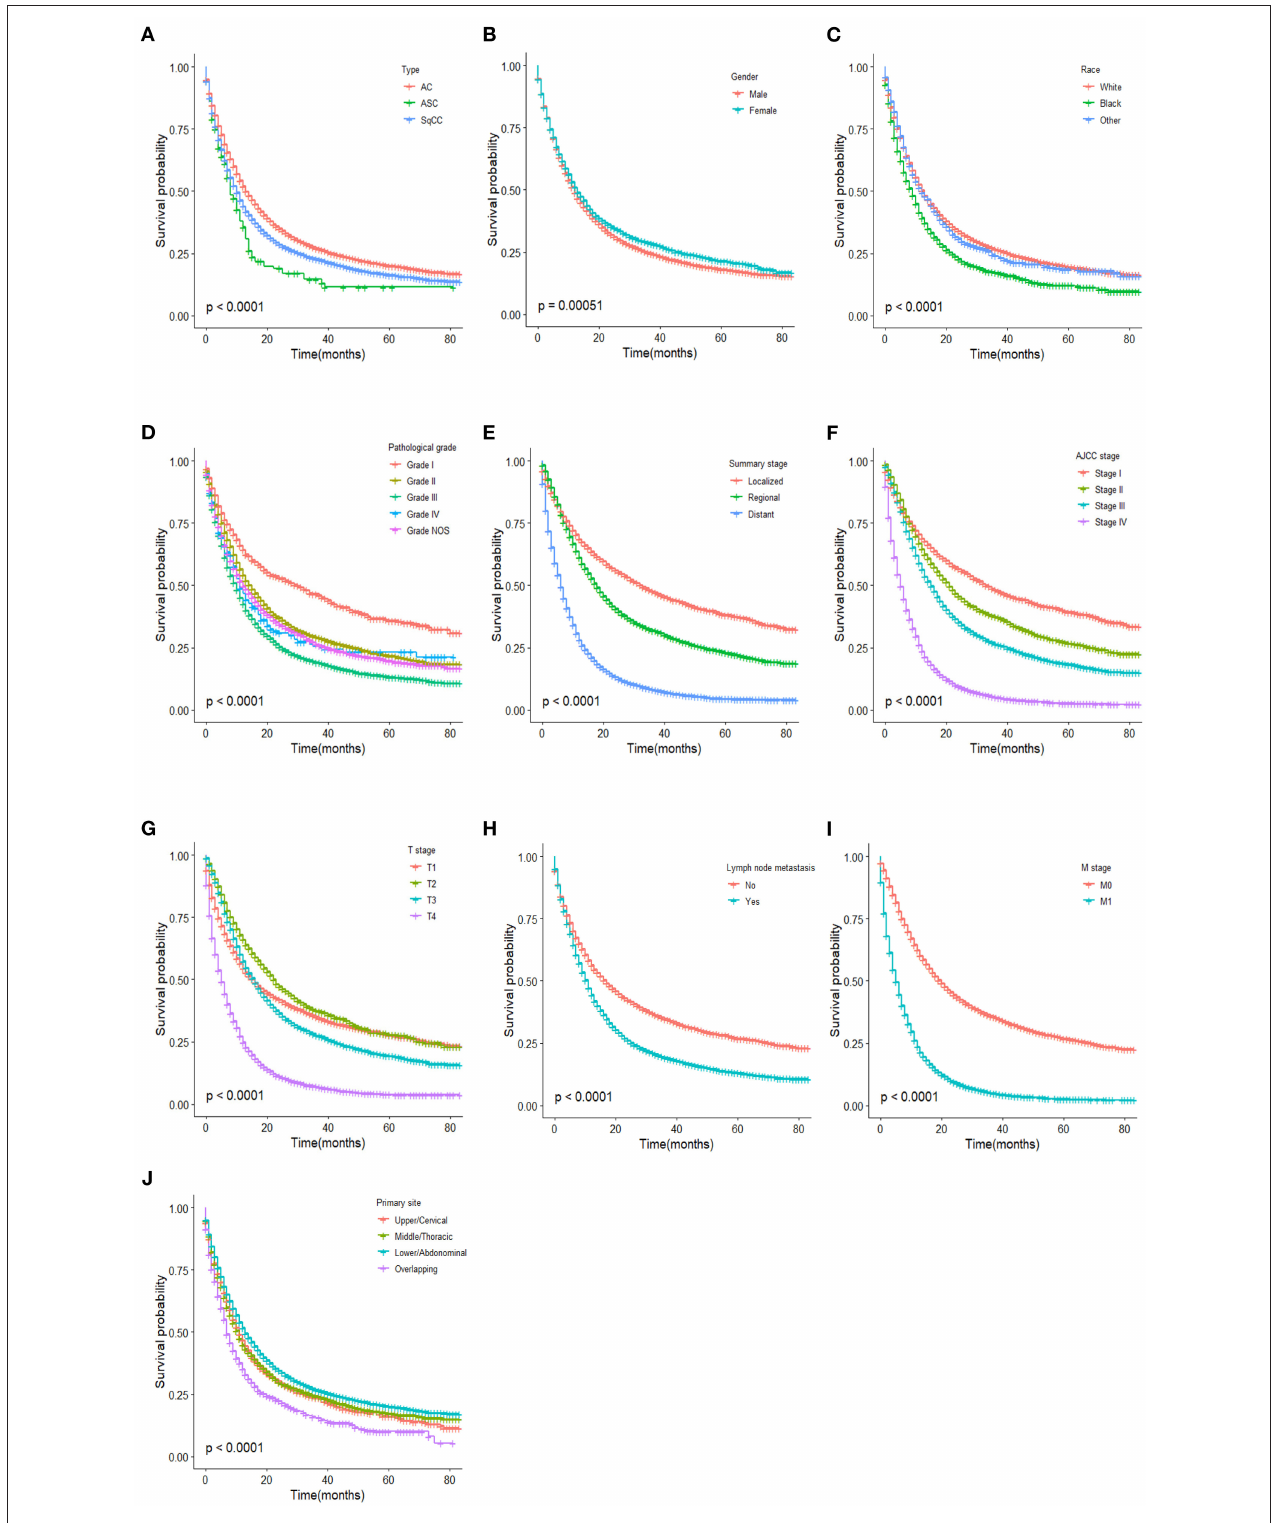
FIGURE 2 | Kaplan–Meier estimated overall survival in patients stratified by type (A) , gender (B) , race (C) , pathological grade (D) , summary stage (E) , AJCC stage (F) , T stage (G) , lymph node metastasis (H) , M stage (I) , primary site (J) .